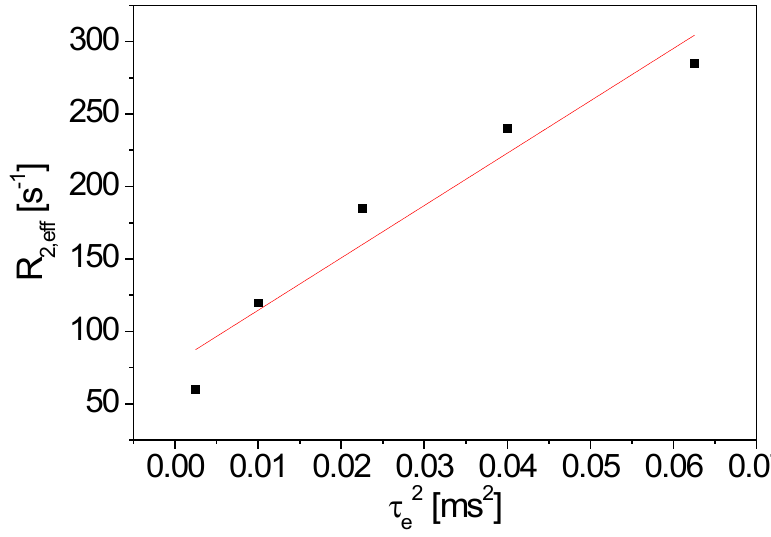
Figure 7. R 2,eff as a function of the squared echo time τ e 2 for an anode slurry of 48.5% w / w graphite, 1% w / w CMC and 0.5% w / w carbon black. The red line evidently shows the deviation from pure trans- verse relaxation and diffusion contributions.